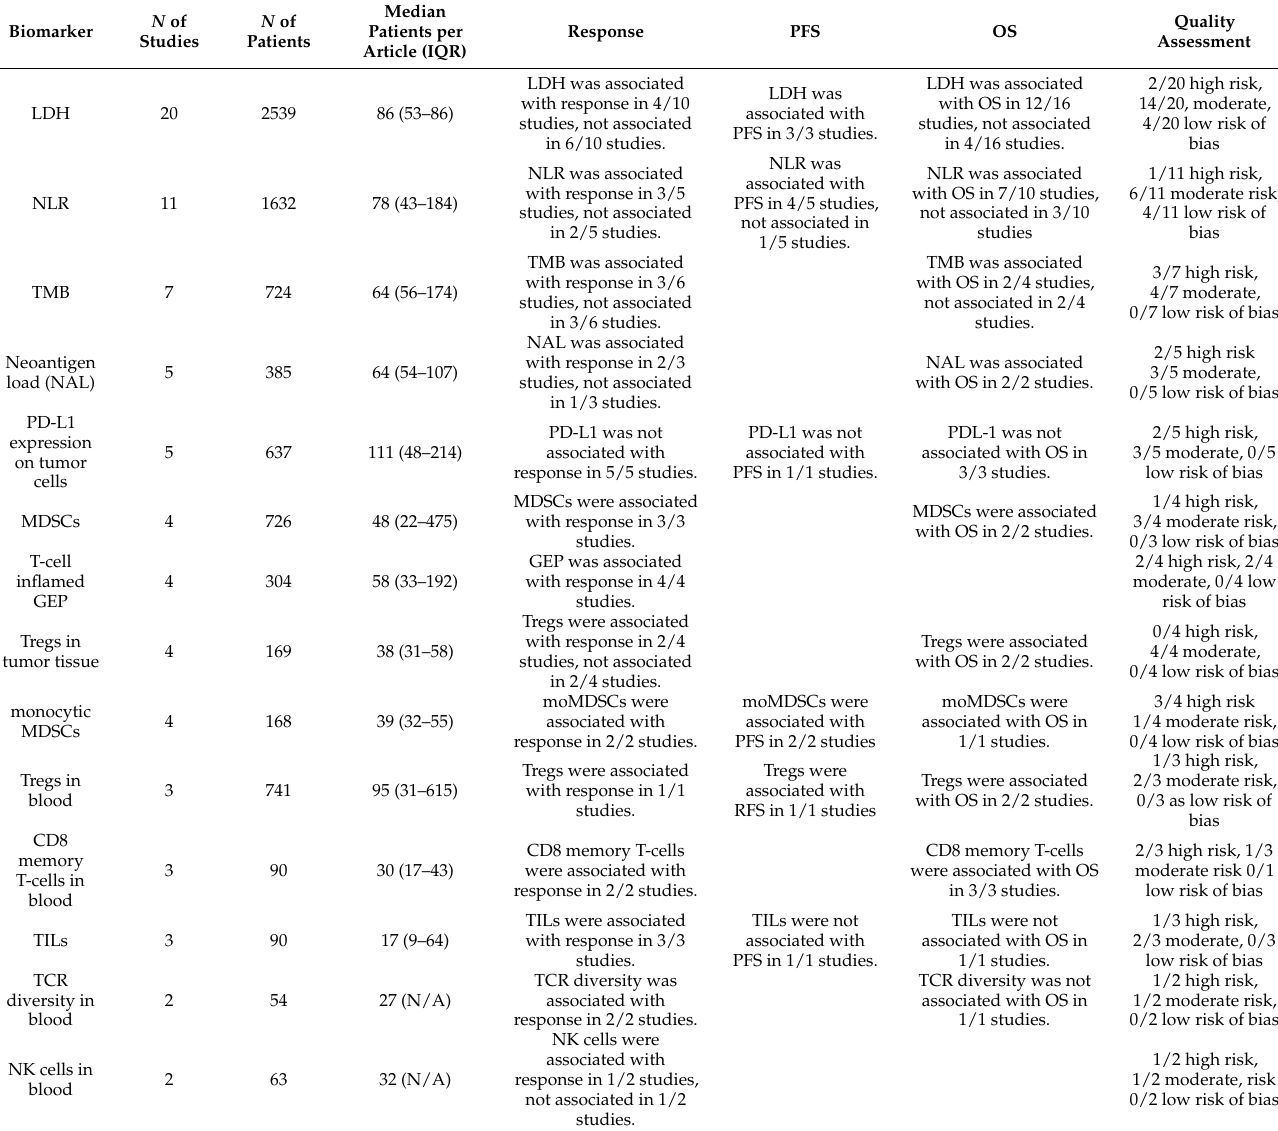
Table 1. Summary of most important biomarkers that were studied for anti-CTLA-4 therapy and assessed risk of bias per article.